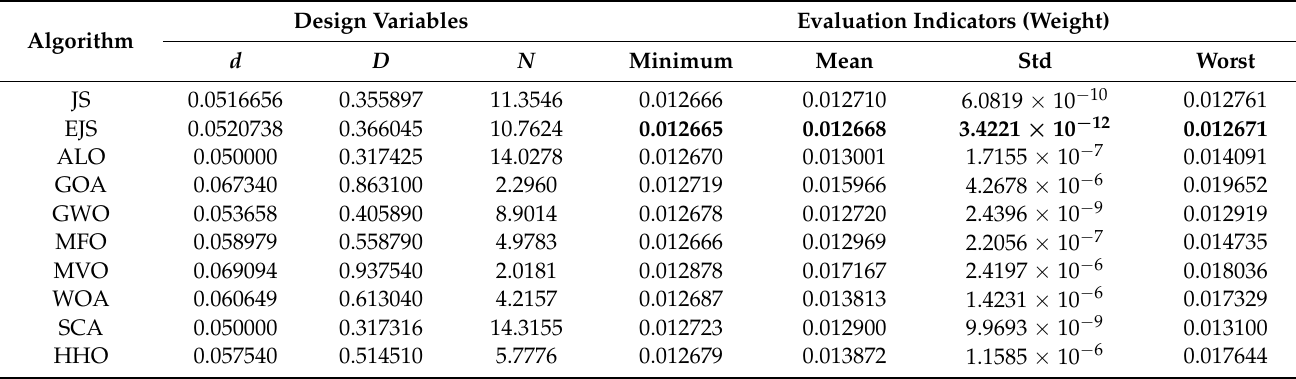
Table 6. Evaluation indicators and variable values for Figure